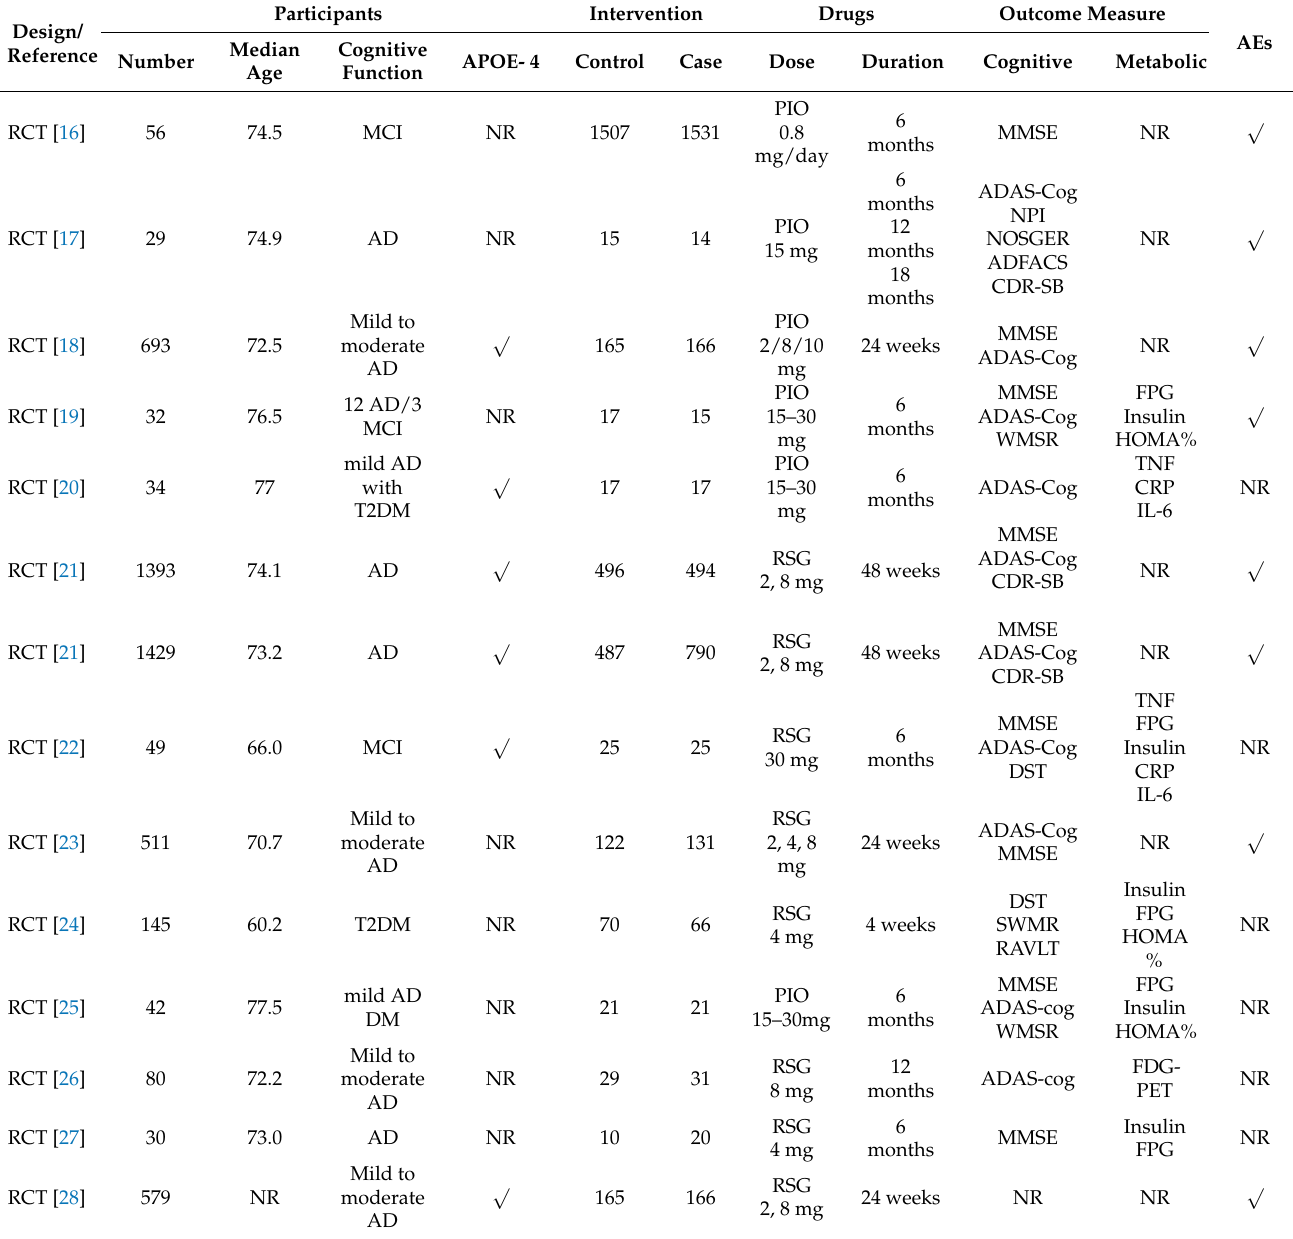
Table 2. Characteristics of included controlled